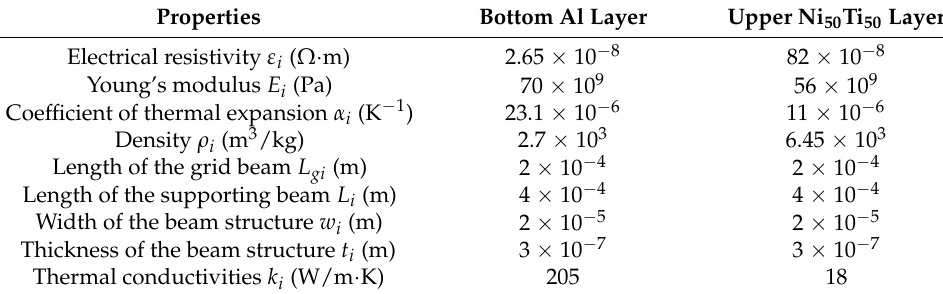
Table 1. Mechanical and dimensional properties of the materials [33,34].